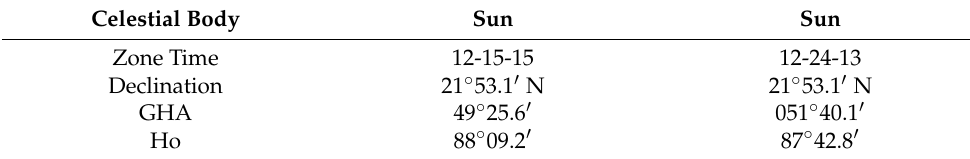
Table 4. The observations data for solving the celestial positioning in Example 2. Celestial Body